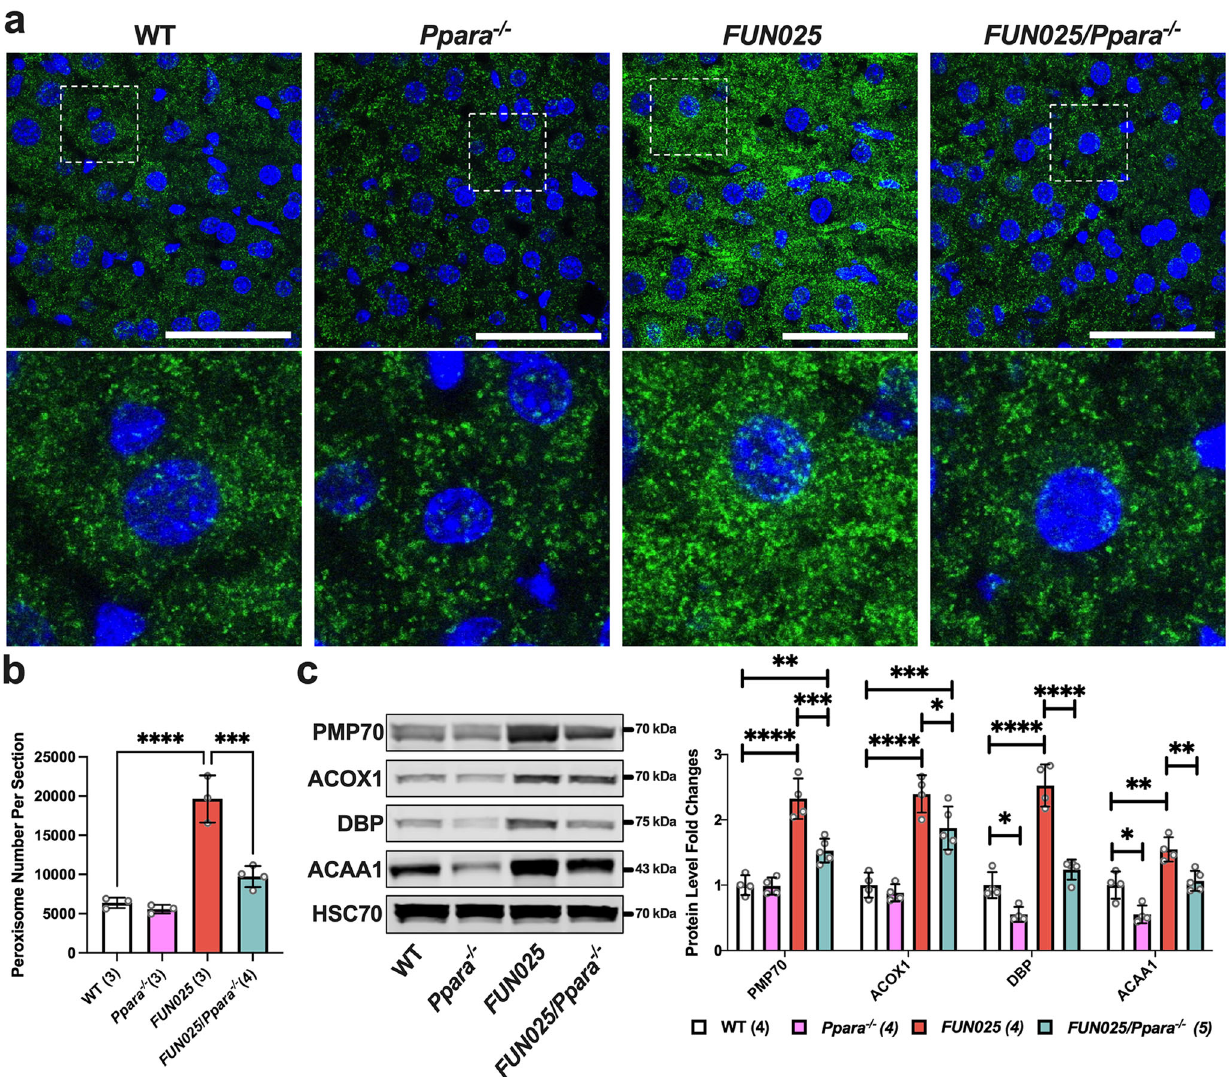
Fig. 6 Tmem135 mutation activates peroxisome proliferator-activated receptor alpha (PPARa) in the mouse liver. a Representative 100x immunohistochemical images of PEX14 labeled (green) and DAPI stained (blue) 3-month-old WT, Ppara − / − , Tmem135 FUN025/FUN025 ( FUN025 ), and Tmem135 FUN025/FUN025 /Ppara − / − ( FUN025 / Ppara − / − ) livers. The white boxes in these images were expanded to highlight differences of the PEX14- positive peroxisome staining between these genotypes. Scale bar for images = 50 microns. b Quantitation of PEX14-positive peroxisomes from the 100x images of WT (1 male/ 2 females), Ppara − / − (1 male/2 females), Tmem135 FUN025/FUN025 (1 male/2 females), and Tmem135 FUN025/FUN025 / Ppara − / − (1 male/ 3 females) livers using the Analyze Particles function in ImageJ. c Western blot analysis of peroxisomal proteins in the livers of 3-month-old WT (3 males/1 female), Ppara − / − (2 males/2 females), Tmem135 FUN025/FUN025 (2 males/2 females), and Tmem135 FUN025/FUN025 / Ppara − / − (3 males/2 females) mice. HSC70 served as the loading control for these experiments. Asterisks (*, **, ***, and ****) indicates post hoc Tukey test for a P < 0.05, P < 0.01, P < 0.001, and P < 0.0001 signi fi cance following a signi fi cant difference detected by one-way ANOVA. PMP70, peroxisomal membrane protein 70. ACOX1, acyl-CoA oxidase 1. DBP, D-bifunctional protein. ACAA1, acetyl-Coenzyme A acyltransferase 1. Dots represent individual data points. Number in parentheses represents N of independent mouse samples per genotype used in the experiment. The protein size next to the immunoblot images denotes the size of the immunoband measured for this analysis. Data are presented as mean ±